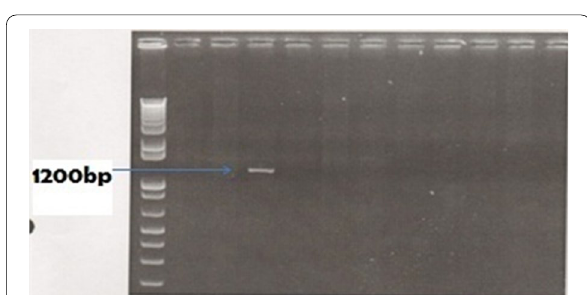
Fig. 2 Molecular detection of CCEV. The figure shows gel electrophoretic separation of PCR products (read from left to